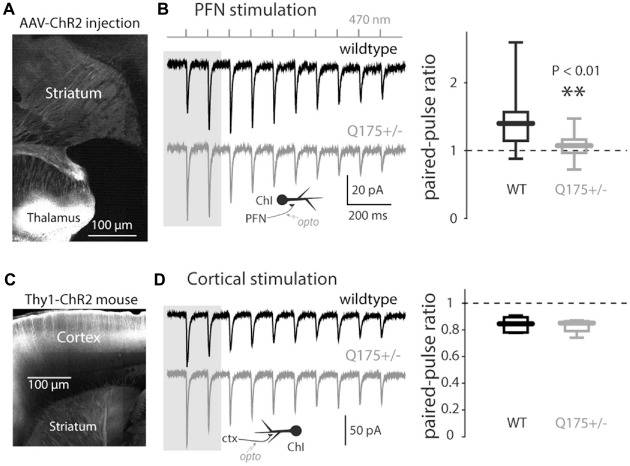
Light-driven paired-pulse ratios (PPRs) of thalamo- and cortico-striatal synapses onto ChIs in the Q175 mouse. (A) Sagittal section with the site of AAV-ChR2 transfection visible in the thalamus and axonal expression in the striatum. (B) Left: examples of trains of optogenetically induced thalamostriatal excitatory postsynaptic currents (EPSCs; 10 Hz) in wildtype (WT), (black trace) and Q175+/− (gray) mice. Inset: schematic of optogenetic stimulation of thalamostriatal axons; Right: boxplot of thalamostriatal PPR values in both genotypes (measured using the first two EPSCs in the train as illustrated by the gray background). (C) Sagittal cortical section in Thy1-ChR2 mice. (D) Left: examples of trains of optogenetically induced corticostriatal EPSCs in WT mice. Inset: schematic of optogenetic stimulation of corticostriatal axons; Right: boxplot of corticostriatal PPR values in both genotypes.